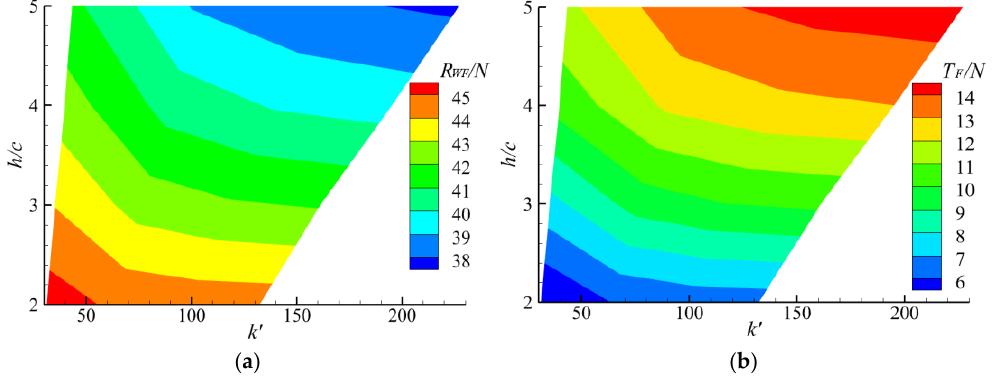
Figure 23. Distribution diagram of hull resistance R WF and flapping foil thrust T F under different span and spring stiffness. ( a ) Hull resistance R WF . ( b ) Flapping foil thrust T F .